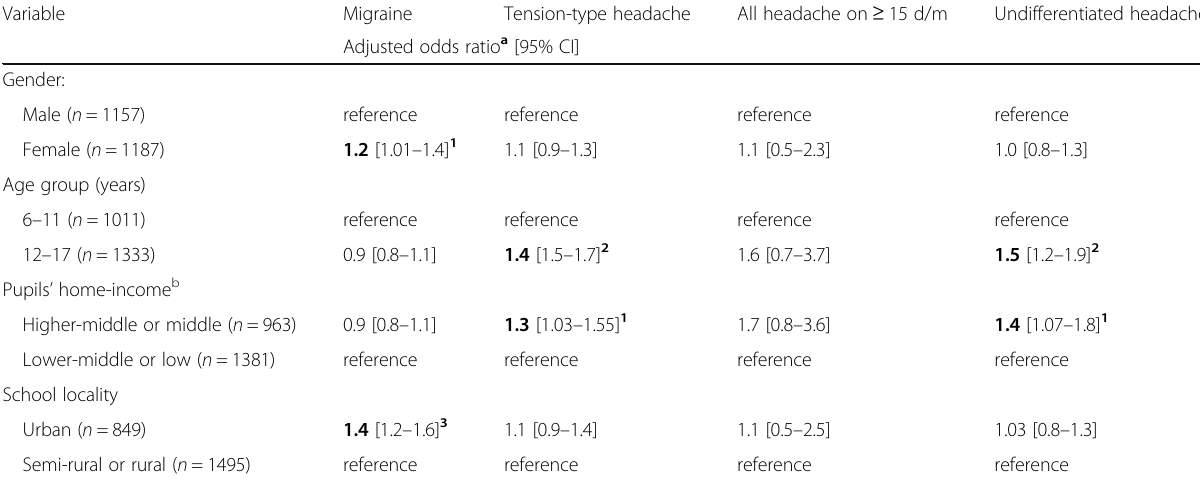
Table 5 Binary logistic regression analysis of associations of headache types with demographic variables ( N = 2344)